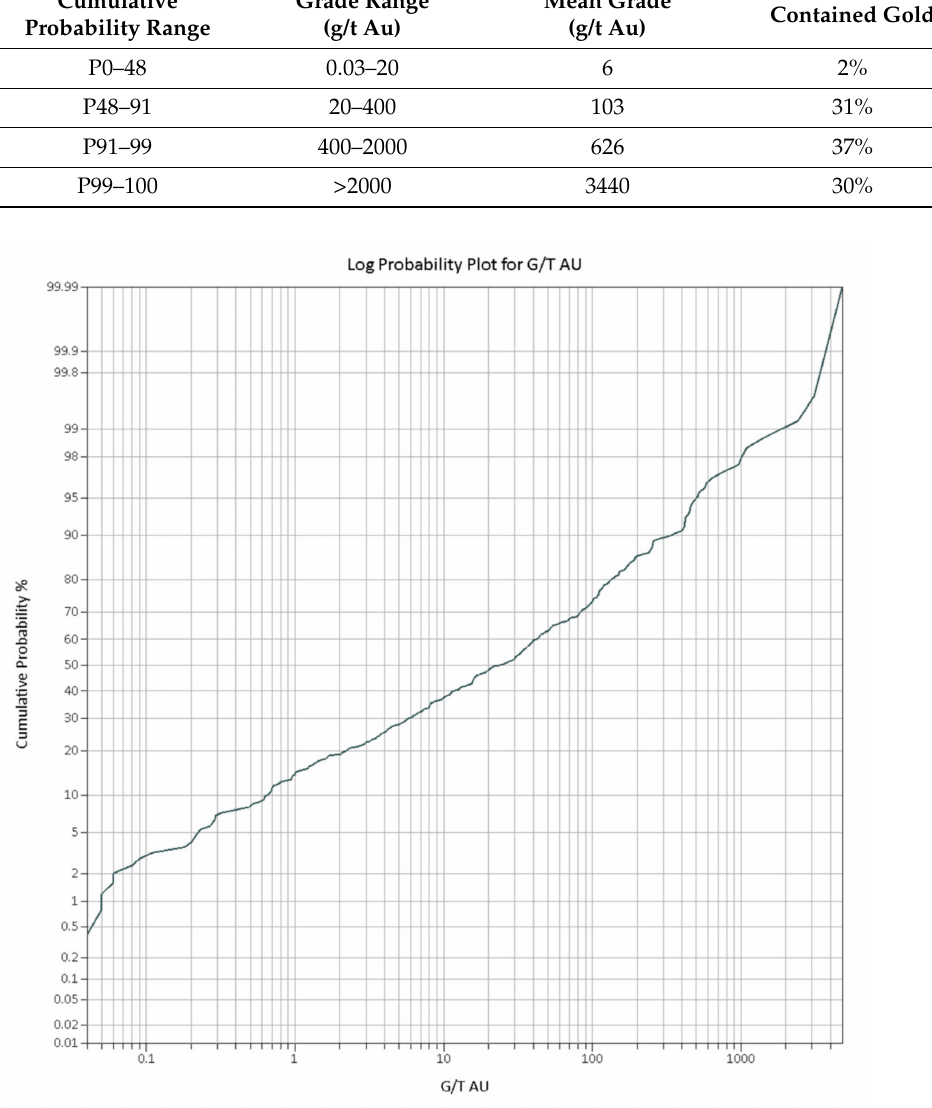
Figure 6. Log-probability plot for LV grades based on 625 face